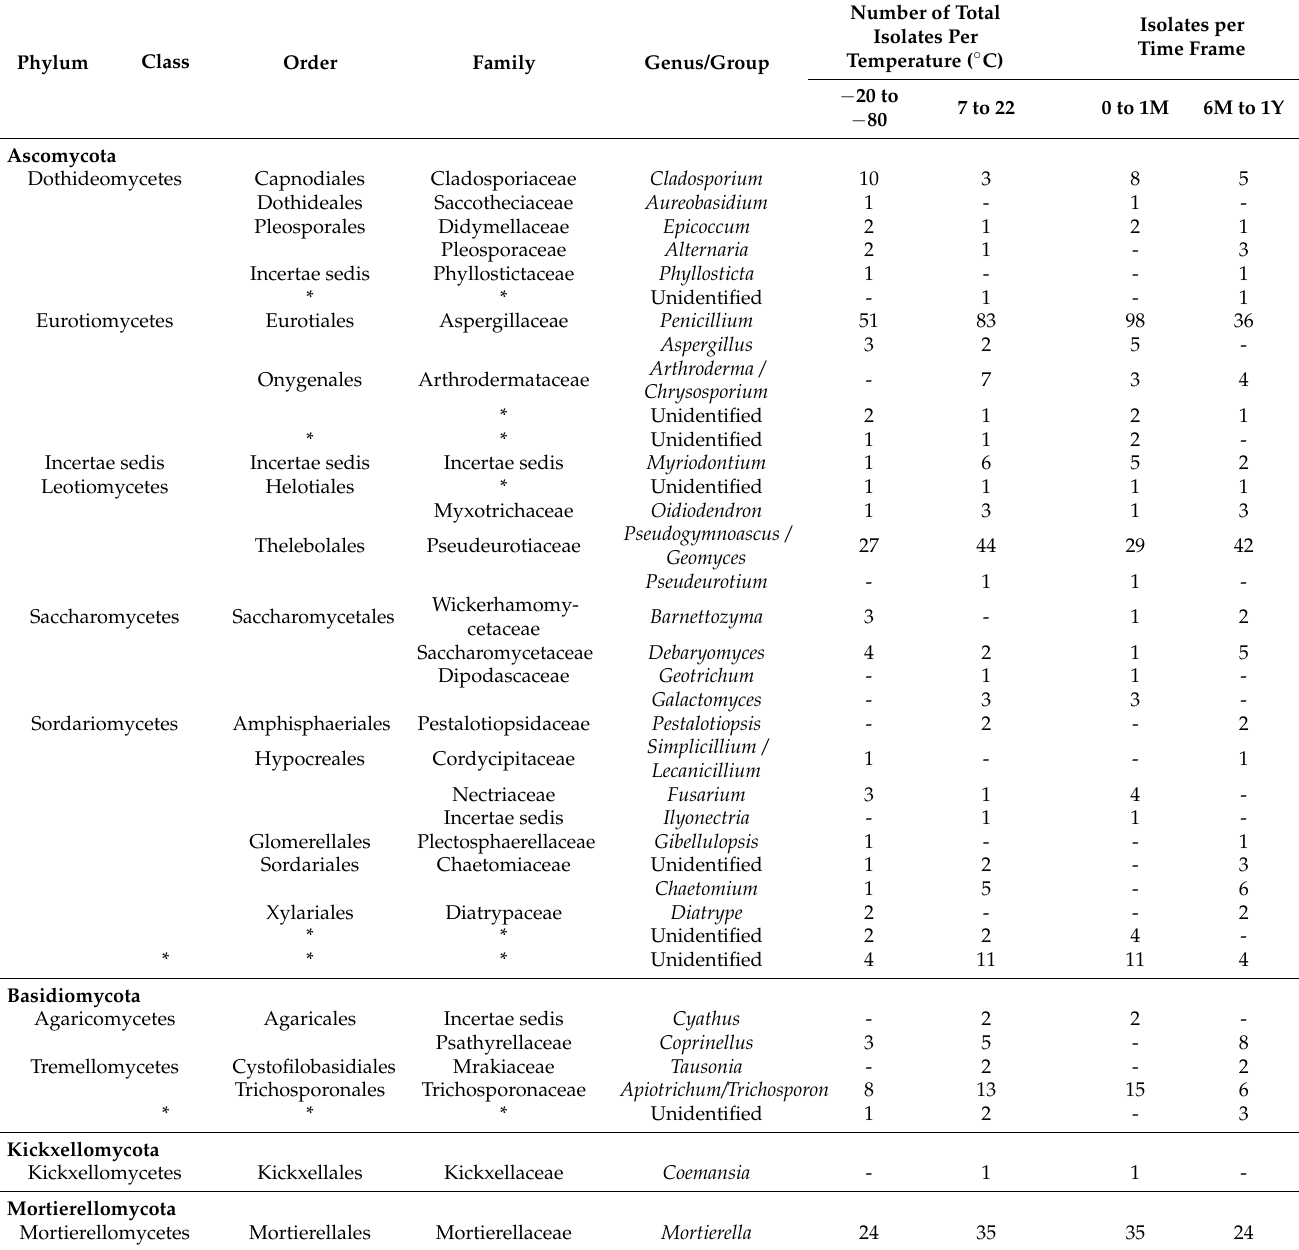
Table 1. Isolated genera from cave sediment samples over the course of one year per storage time and storage temperature.